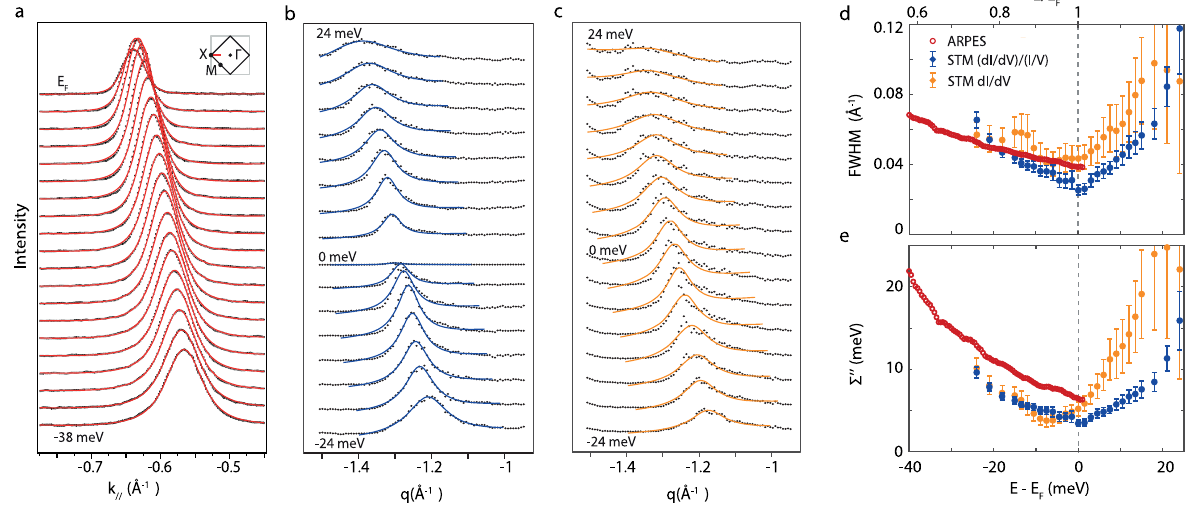
Fig. 5 ARPES and QPI linewidths and self-energies. Linewidth analysis for the β X band. a ARPES MDCs and Lorentzian fi ts (red). The inset shows the position of the cut as red line in the reduced Brillouin zone (black square). b , c STM MDCs from normalized conductance ( dI/dV )/( I/V ) (panel b ) and conductance dI/dV (panel c ) including Lorentzian fi ts (blue and orange, respectively) with a linear background. The cuts are equivalent to the one used in panel a at double the reciprocal lattice vectors. d Comparison of the MDC widths W k ( ω ) from STM and ARPES data. STM widths are phenomenological full-width-half-maximum extracted by Lorentzian fi ts, ARPES widths are extracted by fi tting a Lorentzian convoluted with a Gaussian broadening that stems from the fi nite resolution. e Comparison of the widths multiplied by the slope of the dispersion, which, in a simpli fi ed picture, equals to the imaginary part of the self-energy. Note that the scale of the energy axis spans a signi fi cant fraction of the Fermi energy, which is roughly 400 meV for the β band (in the parabolic band approximation and before hybridization, as we assume that scattering processes that are relevant for the lifetimes do not discriminate between the β X and β M